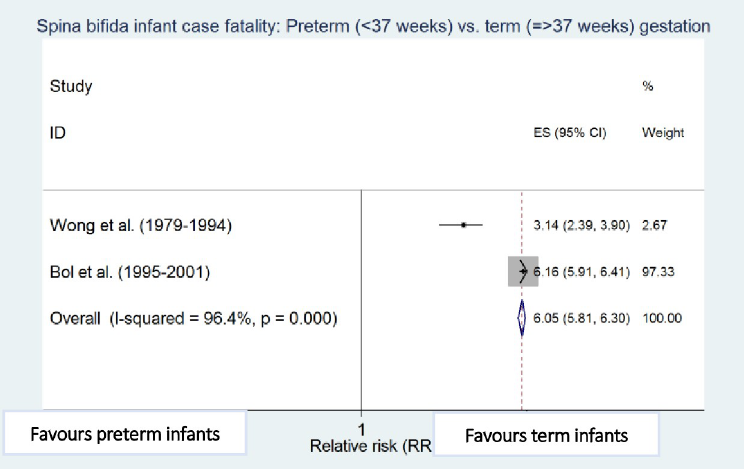
Fig 7. Gestational age. Spina bifida infant case fatality risk factors.